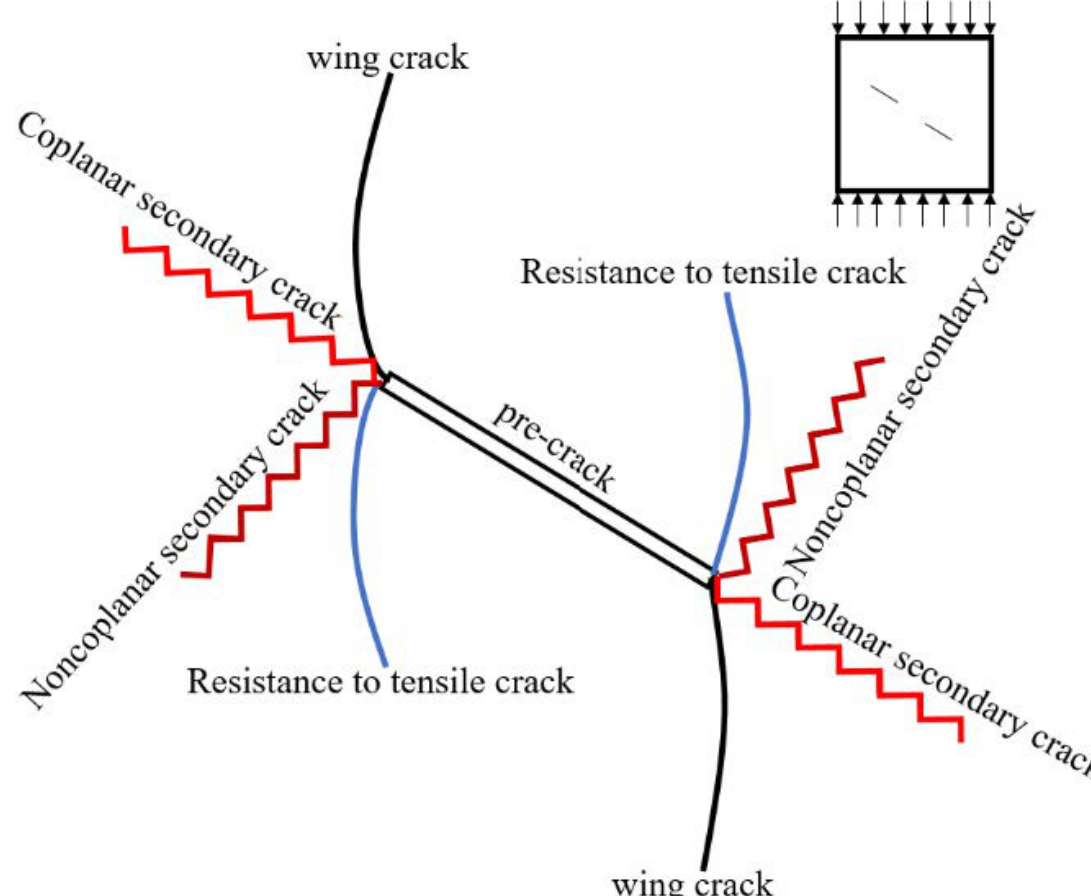
Figure 7. Crack initiation type diagram.